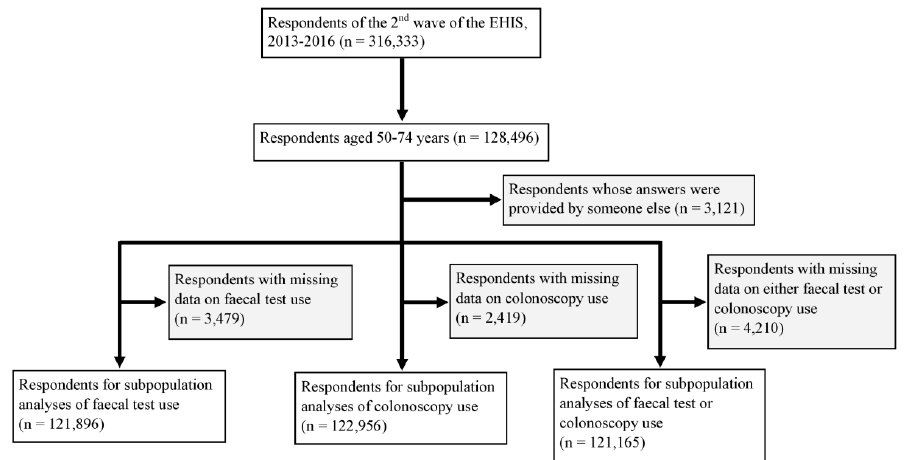
Figure 4. Flowchart of respondents included in, and excluded from, the analyses due to a lack of data on the outcome measures or proxy interviews.